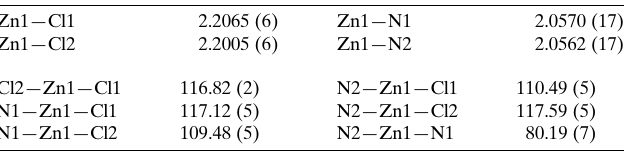
Table 1 Selected geometric parameters (A˚ , (cid:4) ).